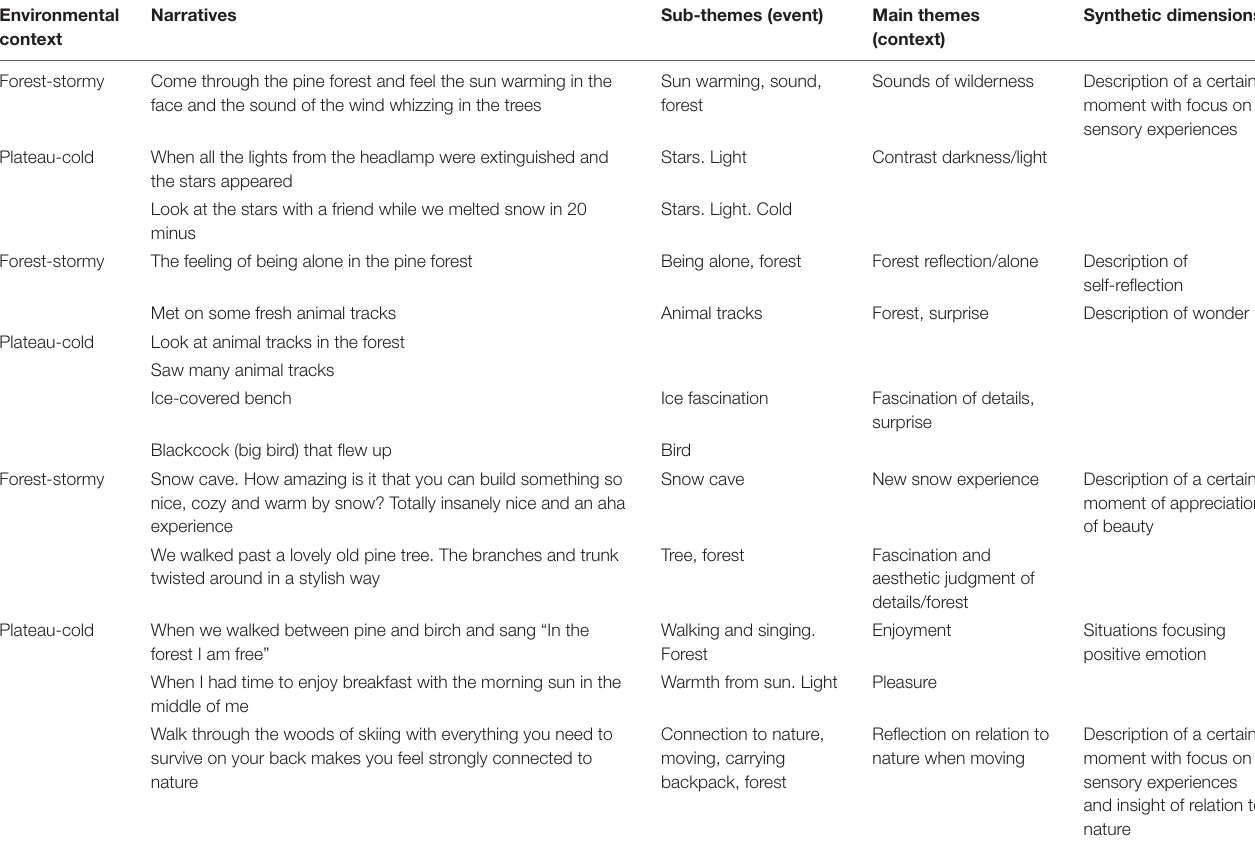
TABLE 3 | Example of the analysis process and developing sub-, main-, and synthetic